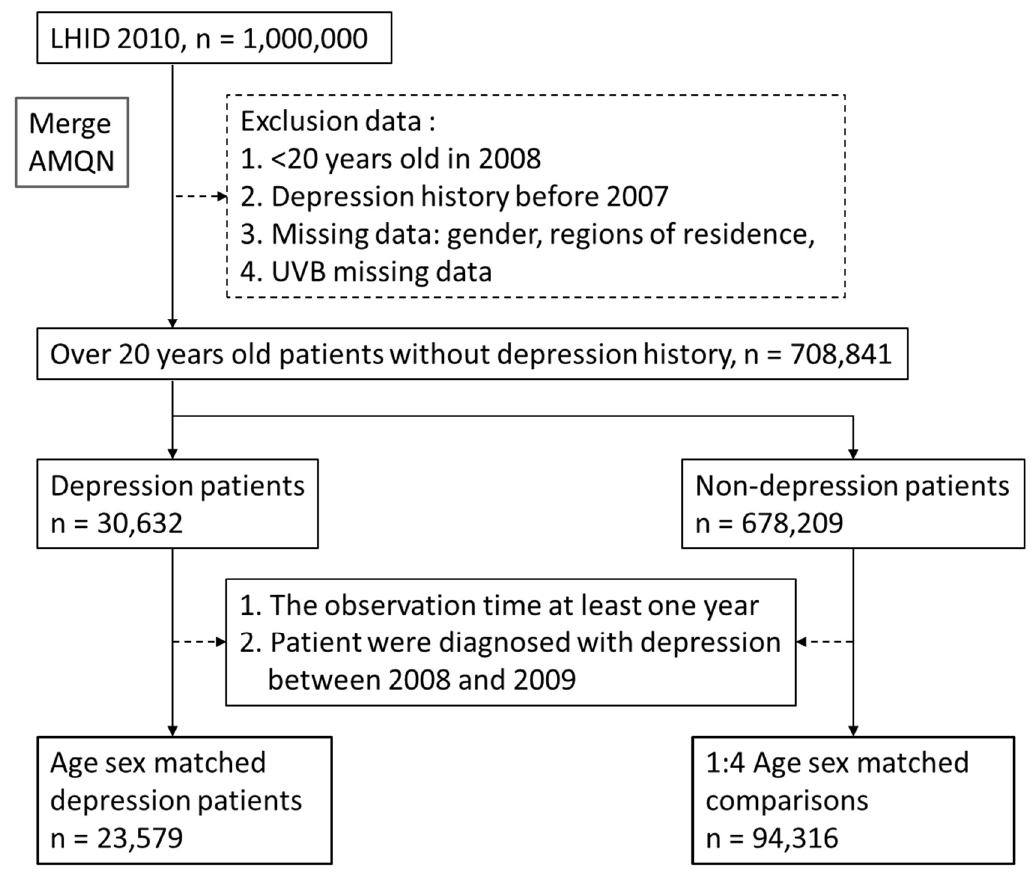
Figure 1. Study flowchart of Depression and comparisons.